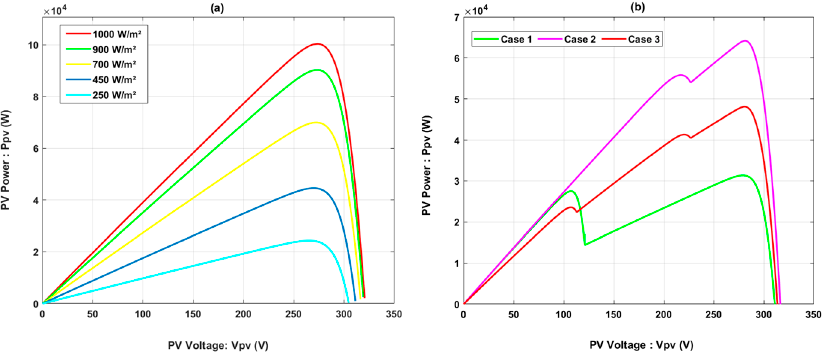
Figure 1. Block diagram of the grid connected PV system.